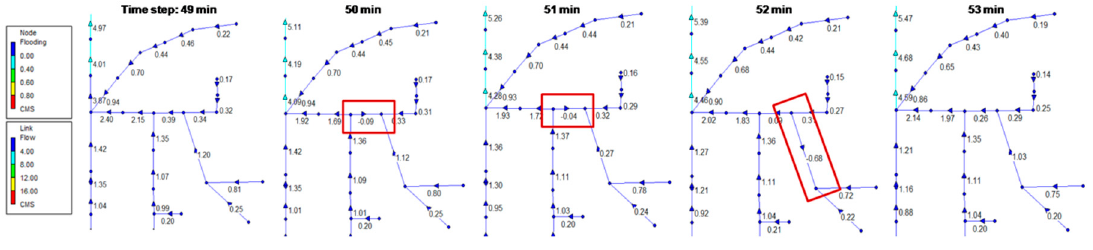
Figure 8. The locations and durations of using backwater effects to provide temporary storages in the case study UDS during peak flow hours.